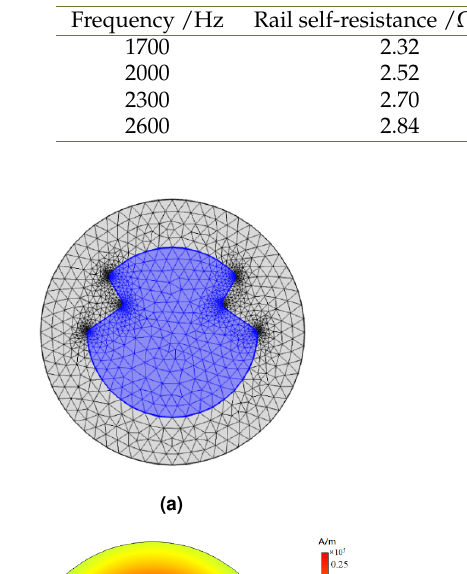
Table 1. Comparison of time performance and performance with different superpixel methods